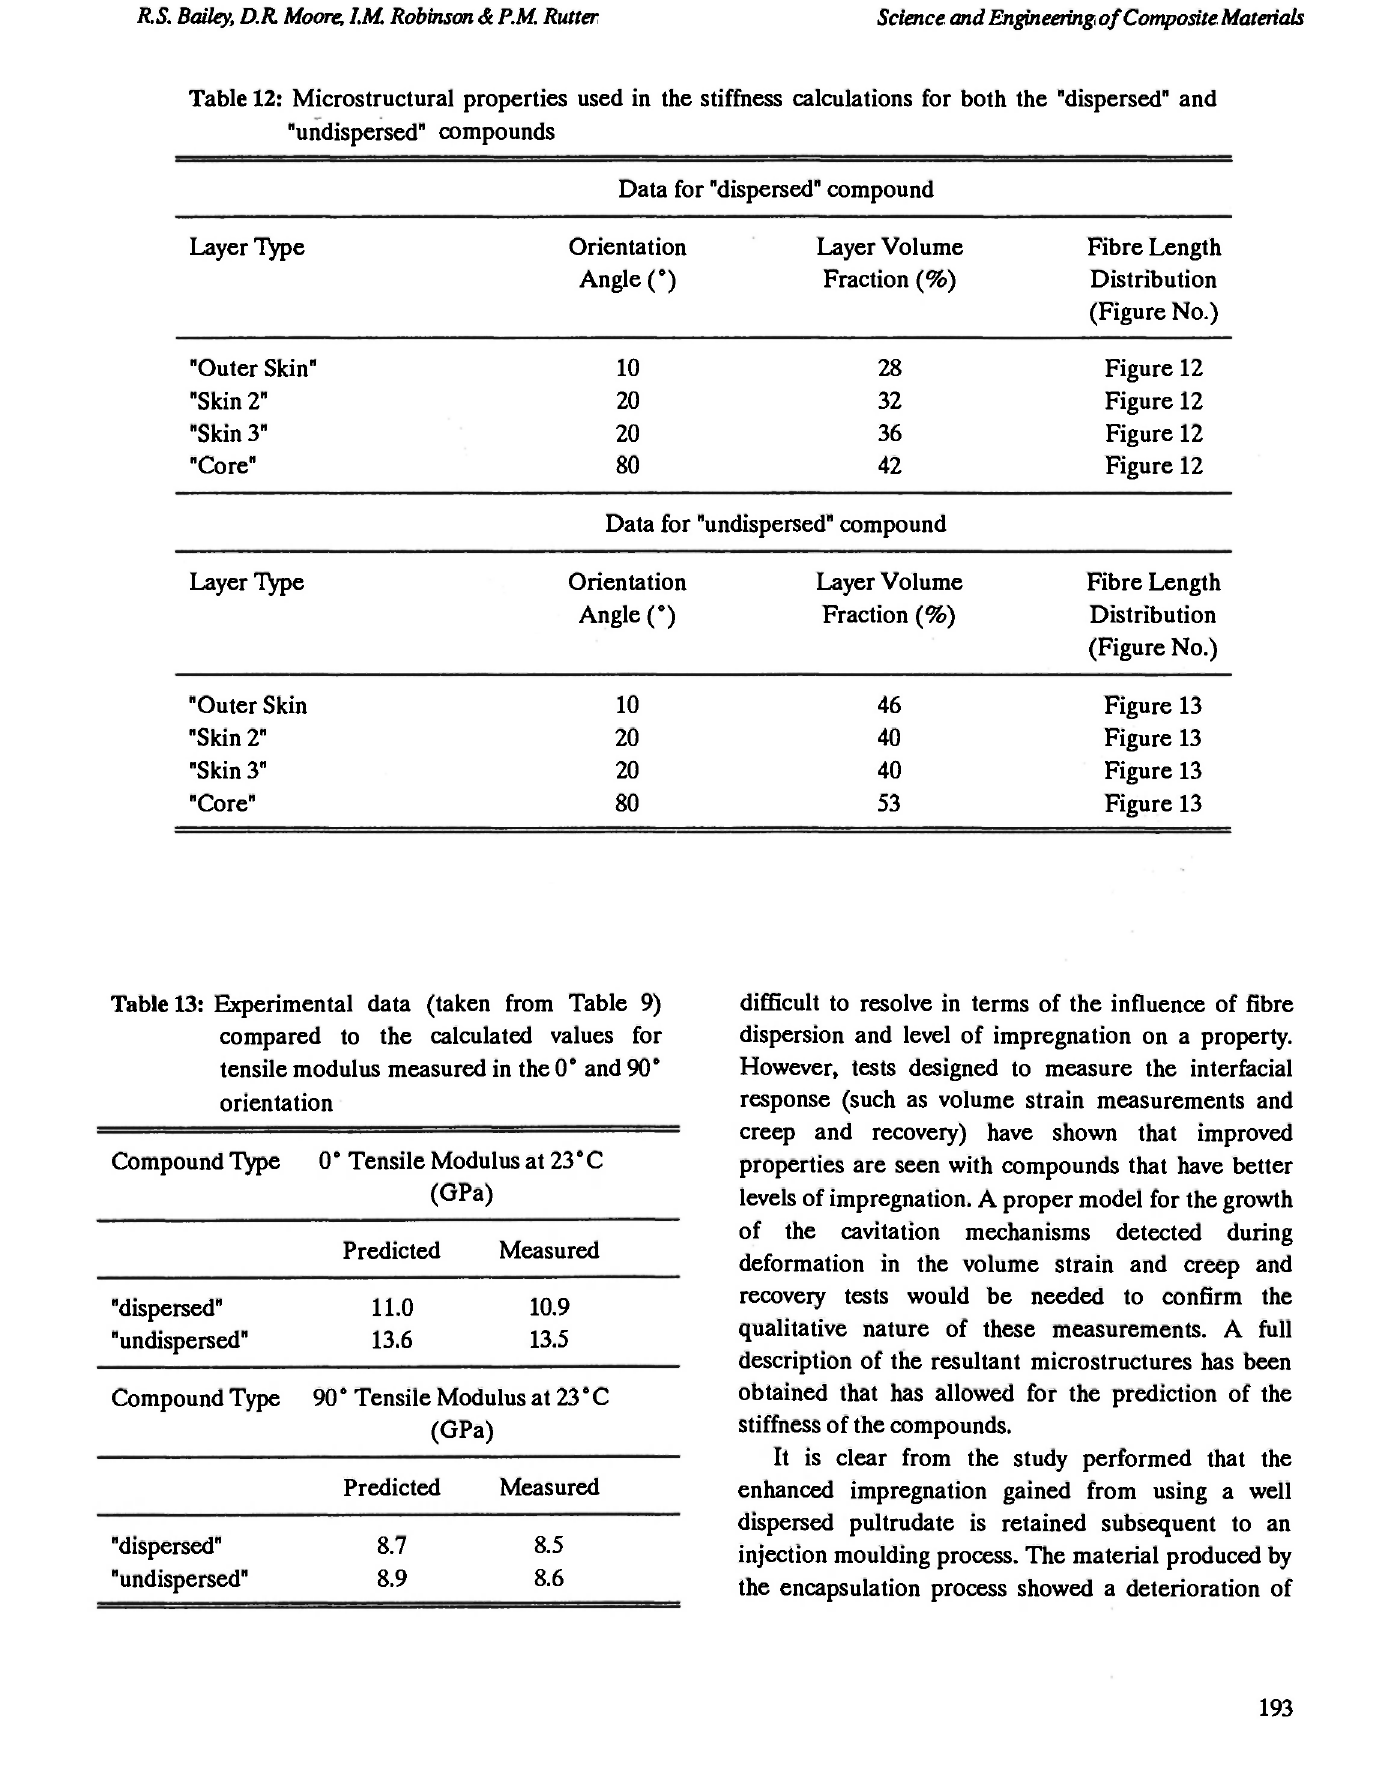
Table 12: Microstructural properties used in the stiffness calculations for both the "dispersed" and "undispersed" compounds